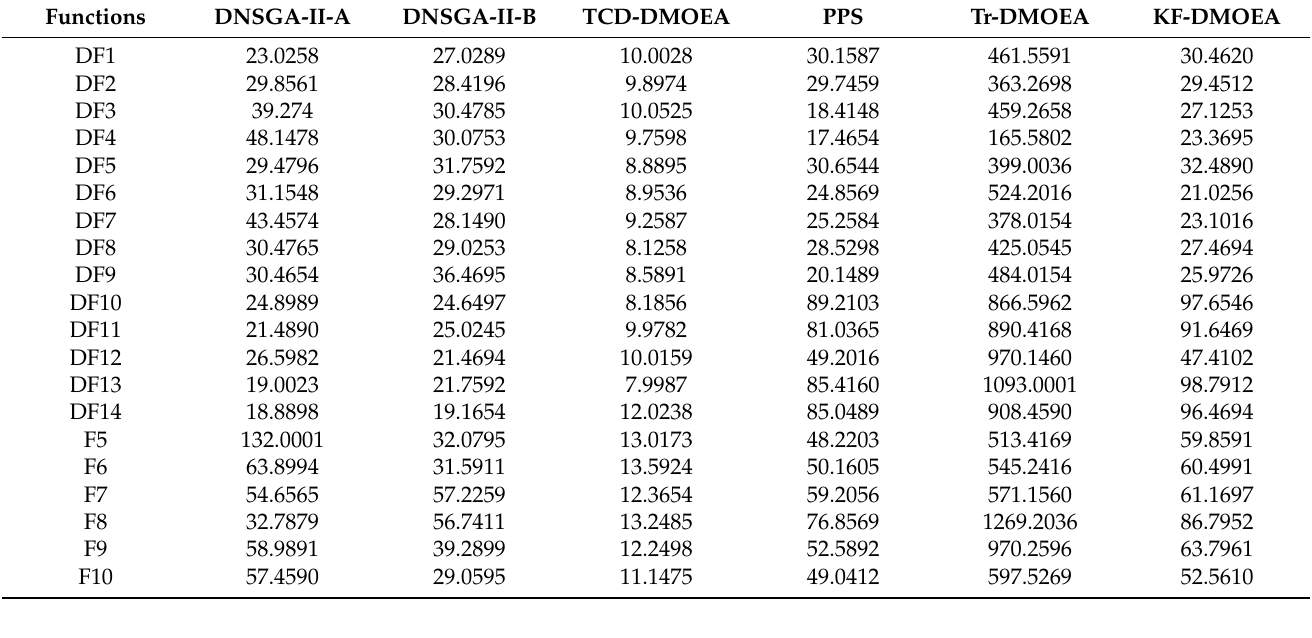
Table 4. The average running time (seconds) of the six algorithms under the S2 configuration.